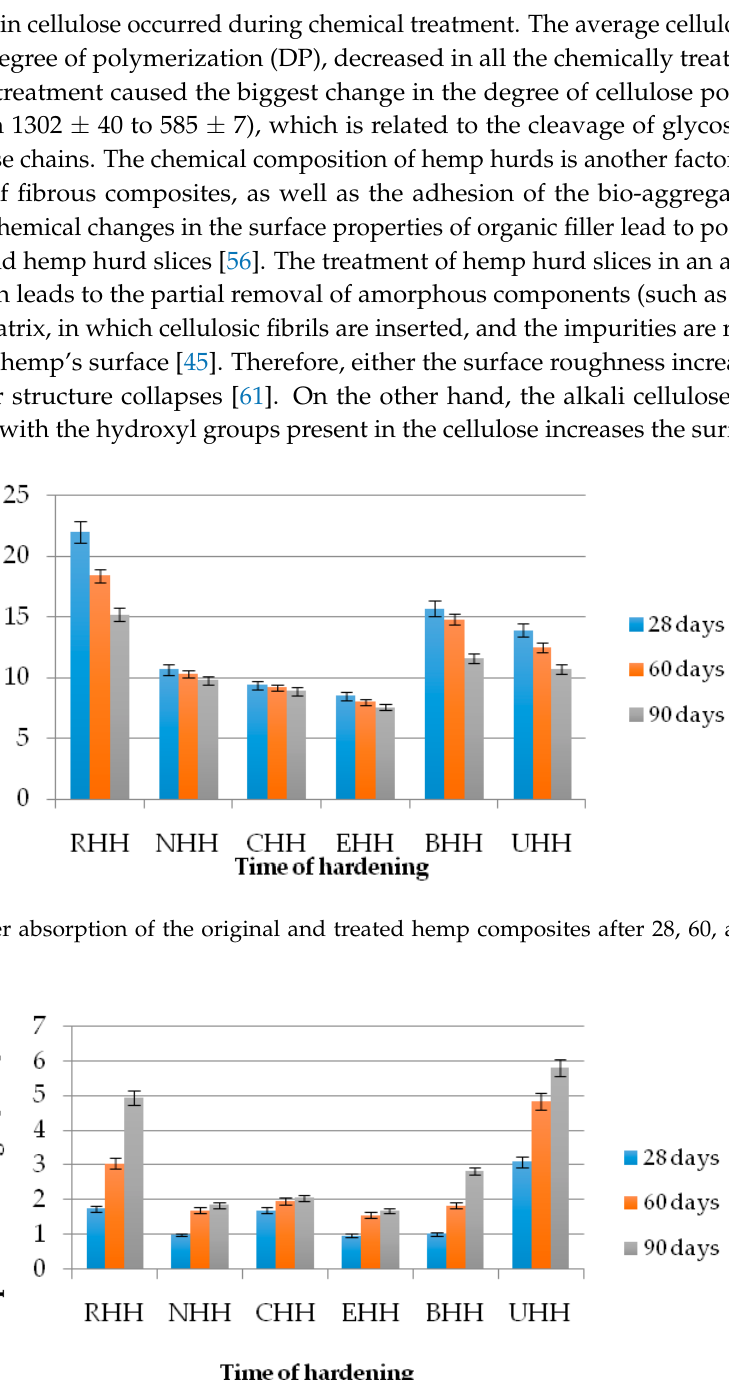
Figure 5. Compressive strength values of the original and treated hemp composites after 28, 60, and 90 days of hardening.